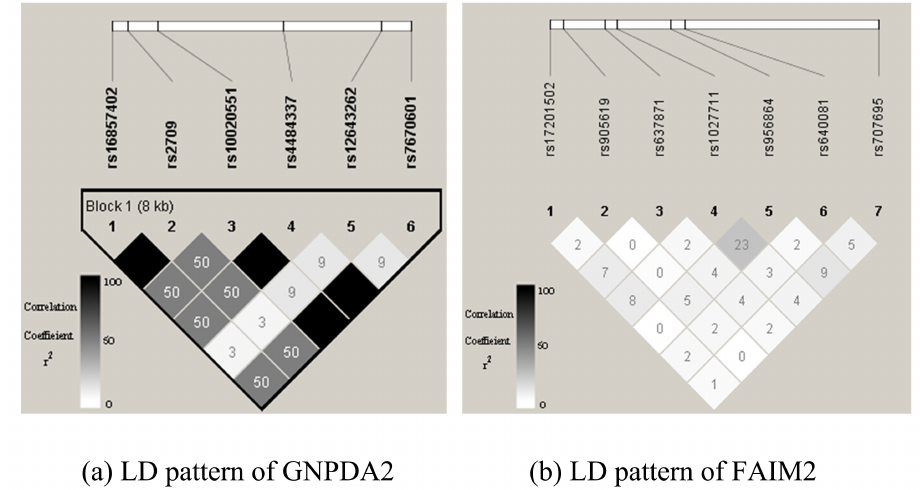
Figure 1. Linkage disequilibrium (LD) patterns of GNPDA2 and FAIM2 used in simulation studies. Figures are LD plots produced using Haploview. GNPDA2 has 6 SNPs, and FAIM2 has 7 SNPs. The number in each square is the LD strength that was measured by r 2 , where 0 ≤ r 2 ≤ 1, 0 means no LD, and 1 means complete LD.